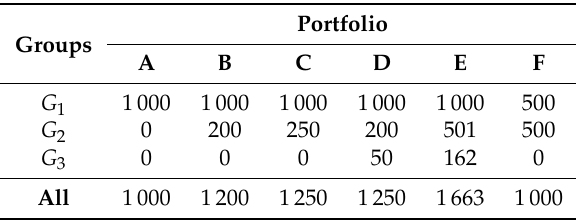
Table 6. Alternative portfolios.